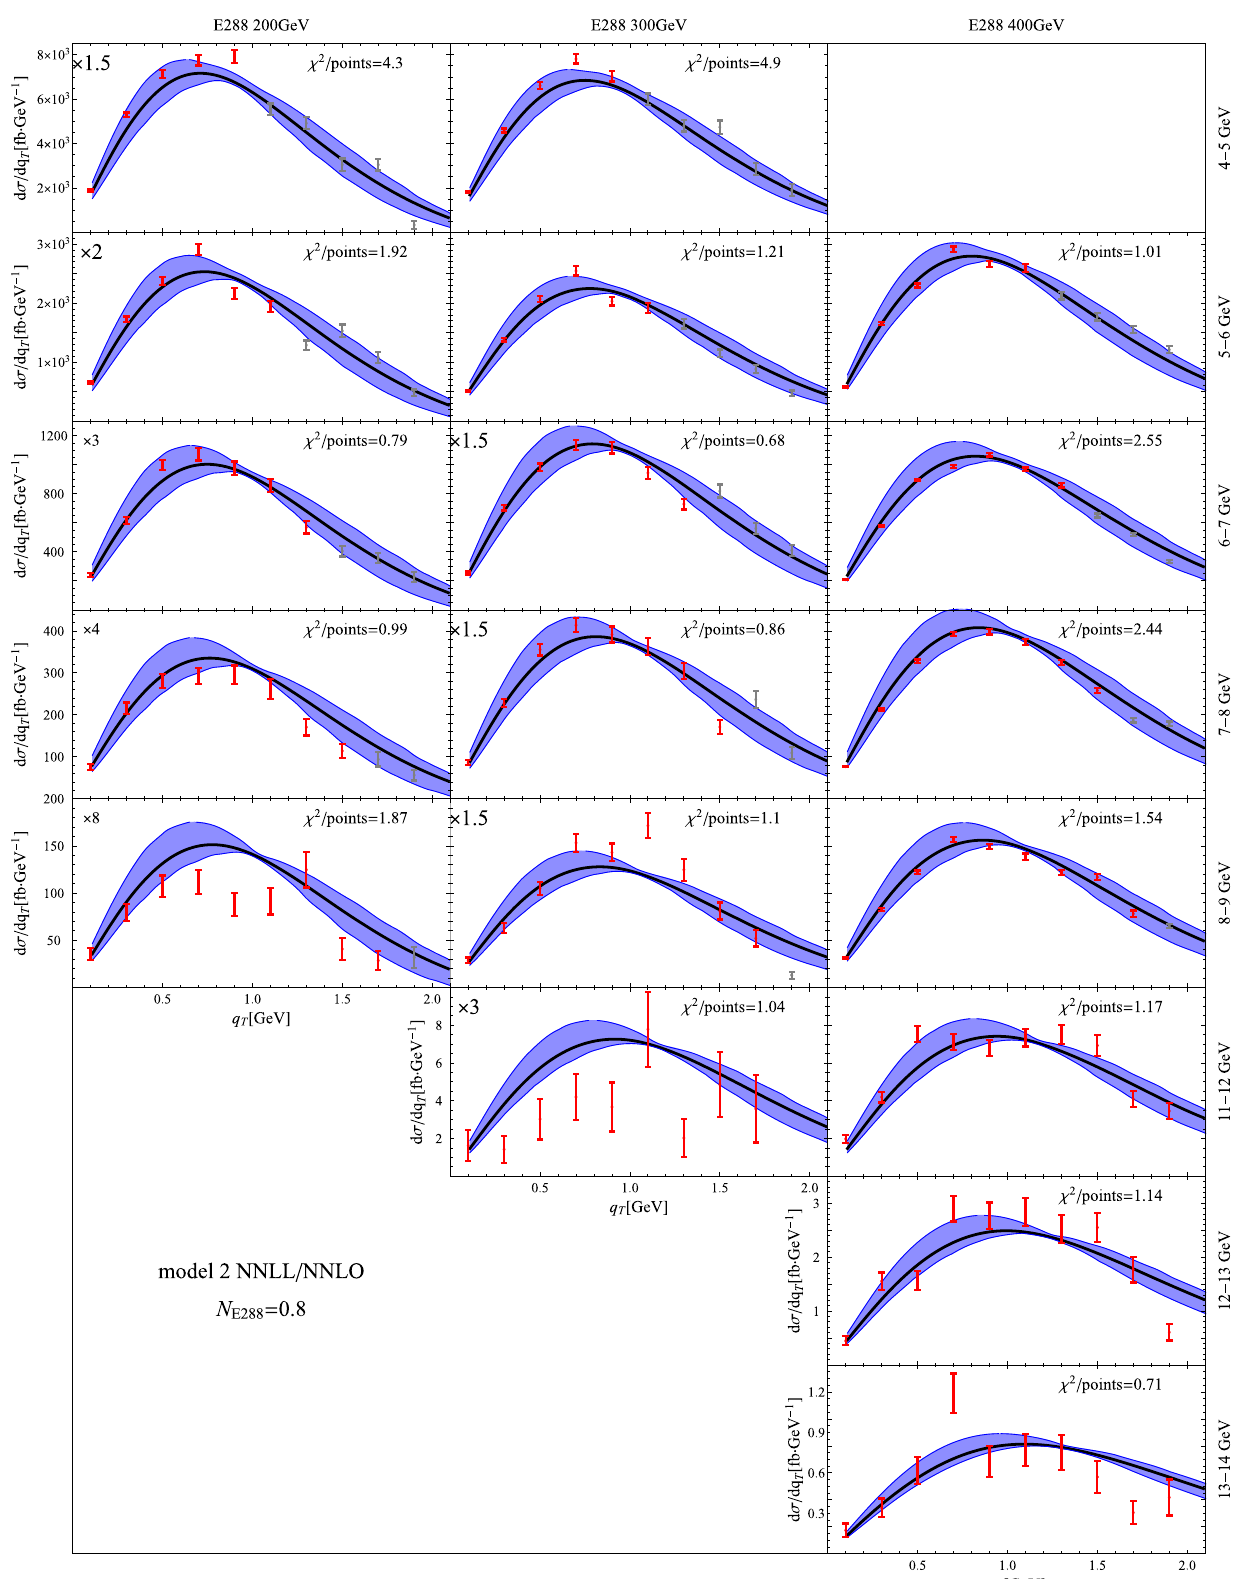
Fig. 14 The comparison of the data for Drell–Yan reaction collected at E288 experiment to the fit of model 2 at NNLL/NNLO. Red data points are those which included in the fit (i.e. with δ T = 0 . 2). Gray data points